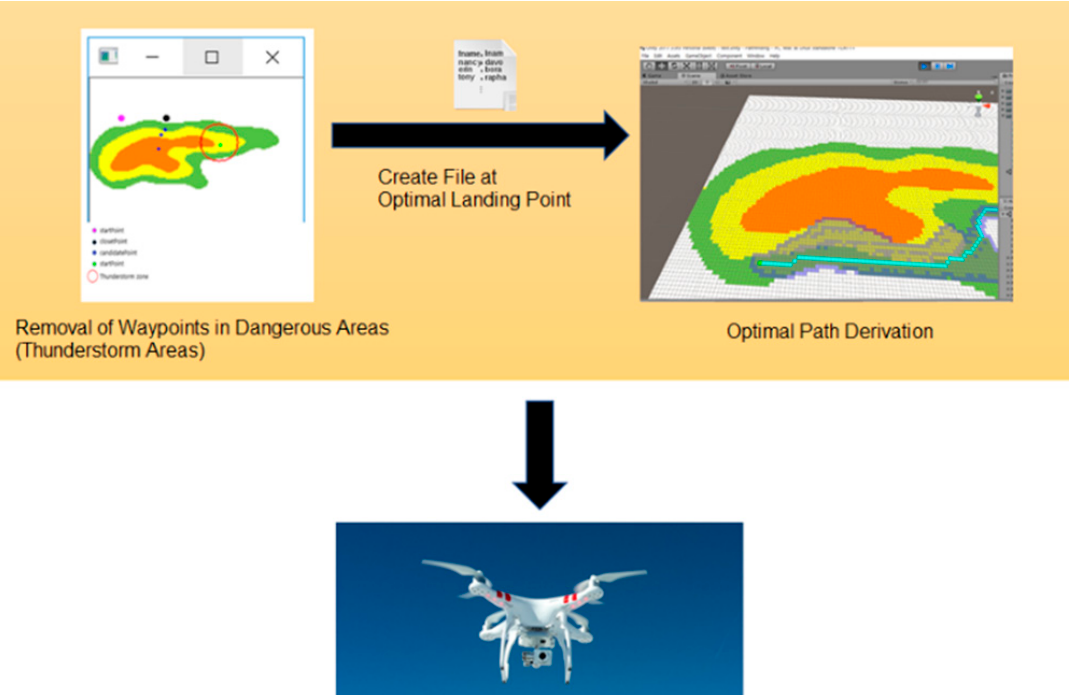
Figure 12. Aerial view of the thunderstorm area avoidance system.